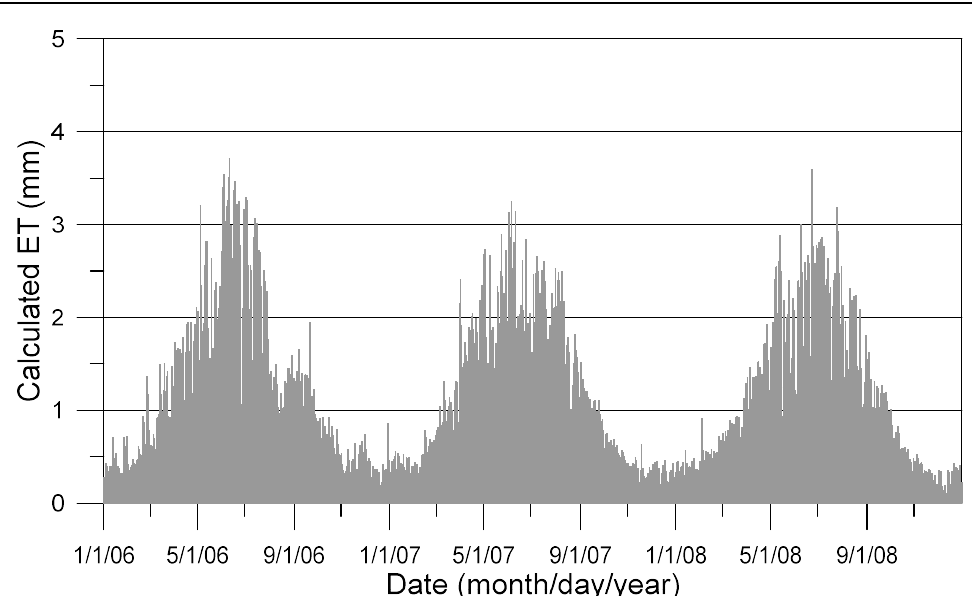
Processes 2022 , 10 , x FOR PEER REVIEW Figure 7. Calculated ET for Newbury cutting. Figure 7. Calculated ET for Newbury cutting.